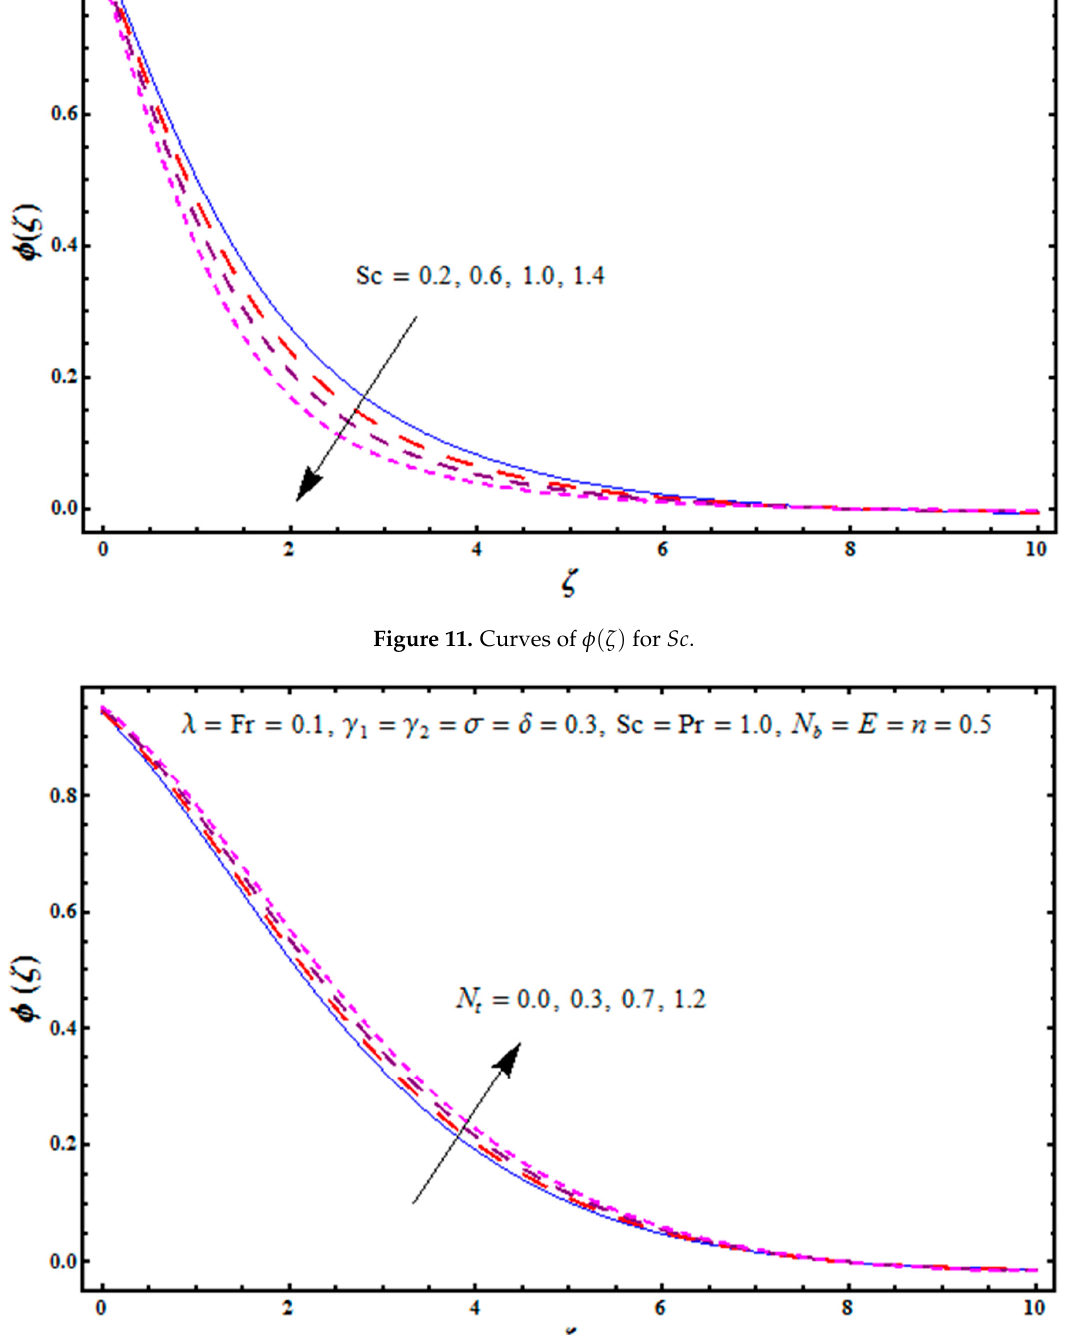
Figure 12. Curves of φ ( ζ ) for N t